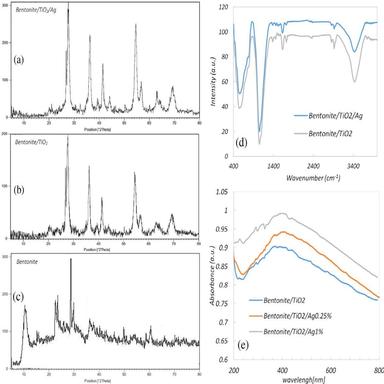
(a-c) XRD results of Bentonite, Bentonite/TiO2, and Bentonite/TiO2/Ag, (d) FTIR results of Bentonite/TiO2 and Bentonite/TiO2/Ag, and (e) UV–Vis results of Bentonite/TiO2, Bentonite/TiO2/Ag0.25%, and Bentonite/TiO2/Ag1%.